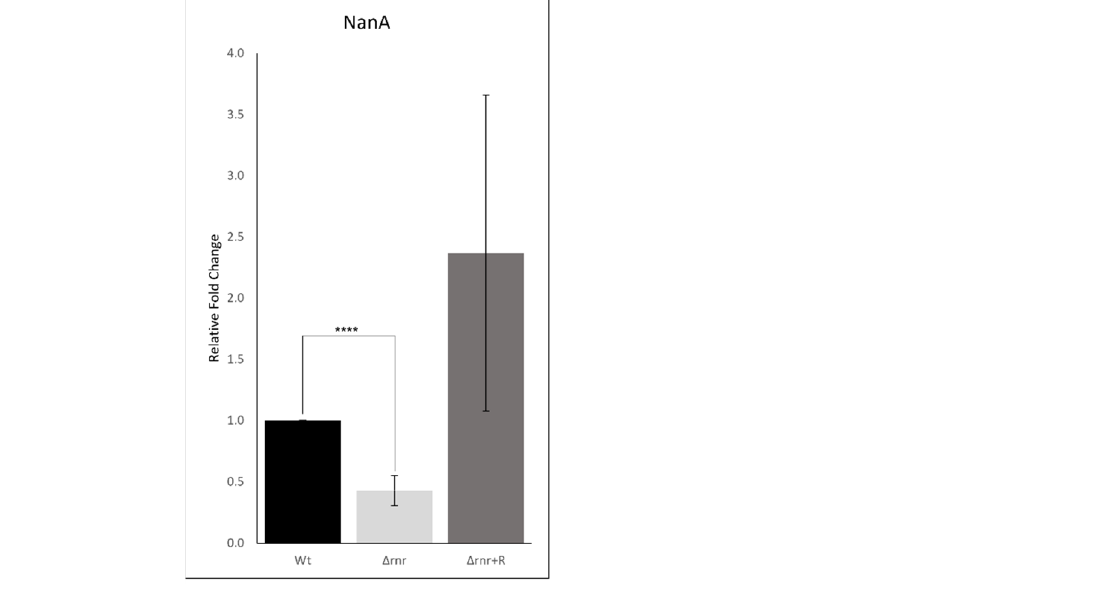
Figure 6. Comparative expression of NanA message by S. pneumoniae wild type and derivatives. The transcriptional levels of NanA were determined by quantitative RT-PCR analysis in exponential growing pneumococcal cultures (wild type—wt; Δ rnr ; Δ rnr +R). Results were normalized to the expression of the pneumococcal housekeeping gene recP and are shown relative to the expression levels in the wild type strain. These data are representative of at least three independent experiments (**** p < 0.0001).